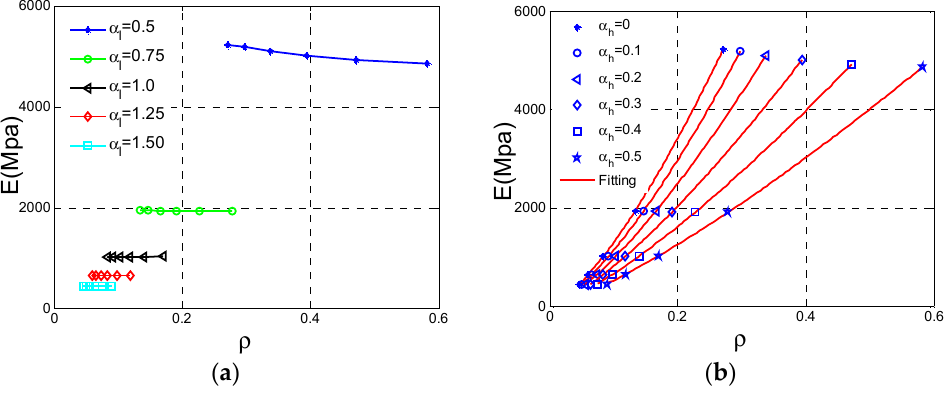
Figure 13. The changes of effective Young’s modulus E for Type C cell with respect to the relative density ρ : ( a ) data set; ( b ) fitting curves. Table 4. Fitting parameters of Type C cell analyses.